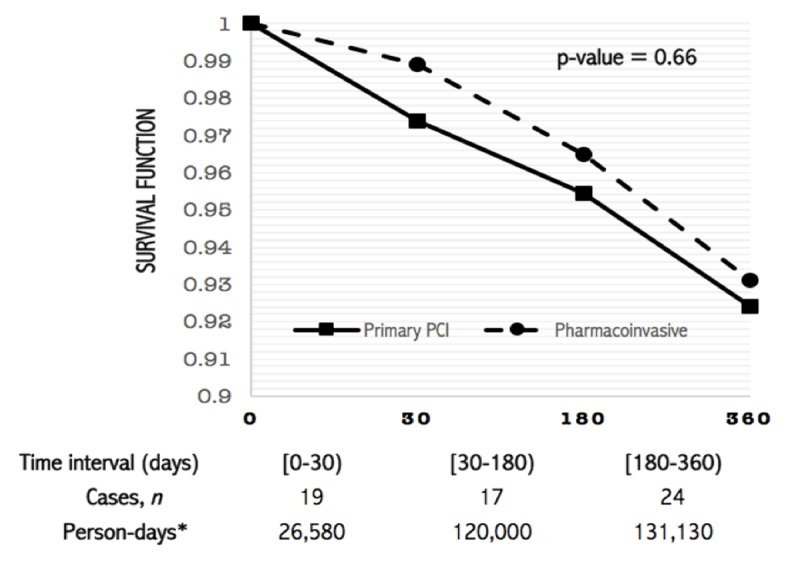
One-year follow-up: Poisson Proportional Hazard Model. No difference was found between primary PCI and PhI in terms of the incidence rate of the composite outcome at one year using survival model looking, after sorting the total of person-days contributed by each individual for three time intervals at 1, 6, and 12 months.